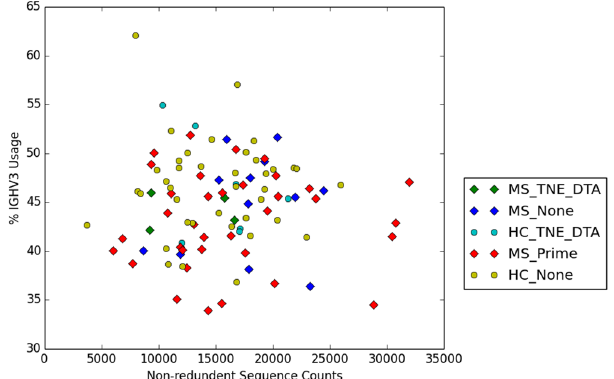
Figure 3. All 51 patients and 46 Healthy Controls are represented in this 2D plot. The x-axis contains the nun- redundant patient sequence counts, obtained from column three of Supplementary Table 1. The y-axis contains the IGHV3 usage percentages obtained from column two of Supplementary Table 5. The data point shapes are determined by patient type. MS patients are represented by diamonds. Healthy Controls are represented by circles. The data points are further subcategorized by match type. Prime motif matches are categorized as “Prime.” TNE and DTA matches are categorized as “TNE_DTA.” All other matches are categorized as “None.” Though a few MS outliers are present in the plot, most patient data points appear to overlap regardless of